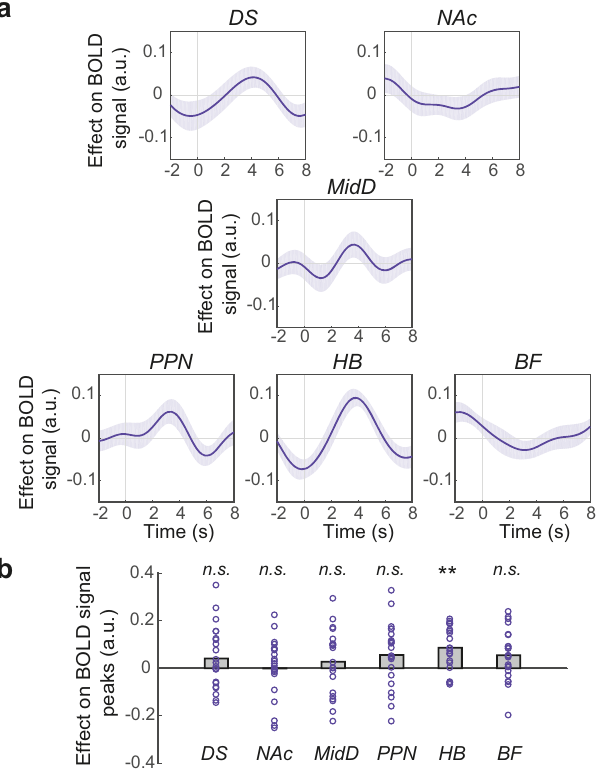
Fig. 3 HB encodes willingness-to-act. a ROI time-course analysis showing the relationship between BOLD activity and willingness-to-act. Format as in Fig. 2a. The lines and shadings show the mean and standard error of the β weights across the participants, respectively. Time zero is the trial onset (appearance of the offer). Note that the hemodynamic lag means that a BOLD signal change re fl ects neural activity approximately 6 s earlier. b